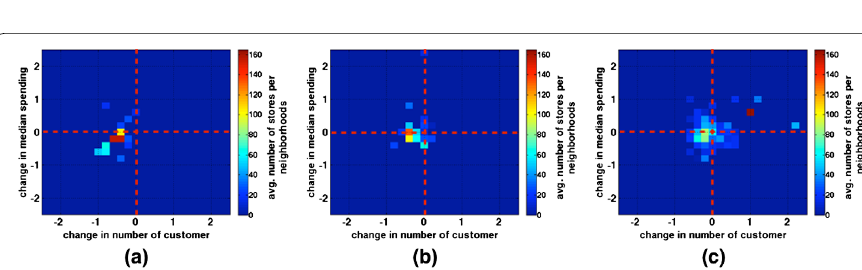
Figure 4 The 2-D histograms of the number of neighborhoods in terms of the two behavioral indexes for Day 62 in the data set: ( a ) within 2 km; ( b ) from 2 to 4 km; ( c ) above 4 km. The horizontal and vertical dashed lines indicate changes of a magnitude less than